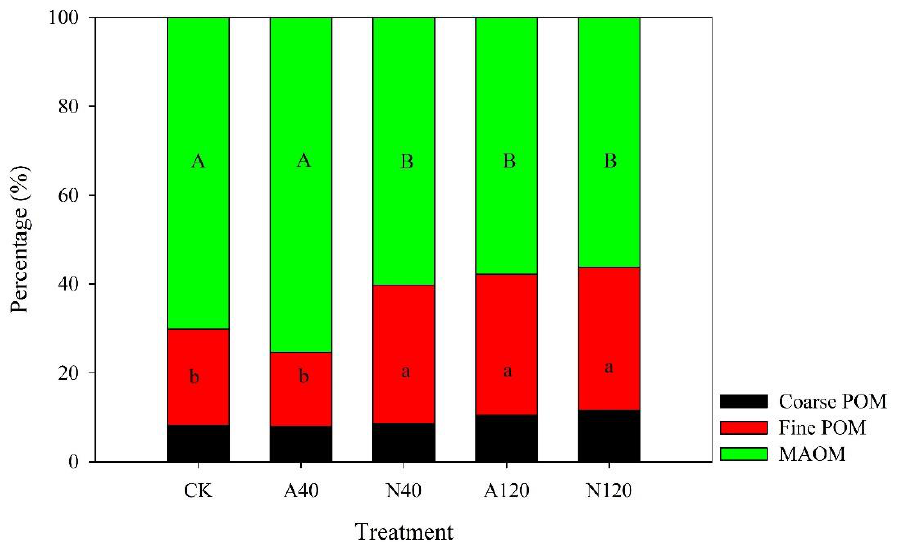
Figure 1. Percentages of three fractions under different treatments. CK, A40, A120, N40, and N120 are control, low (40 kg N ha − 1 yr − 1 ), and high (120 kg N ha − 1 yr − 1 ) rates of NH 4 Cl and NaNO 3 application, respectively. Different lowercases and uppercases represent significant differences between control and N treatments in fine particulate organic matter (POM) and mineral-associated organic matter (MAOM), respectively.